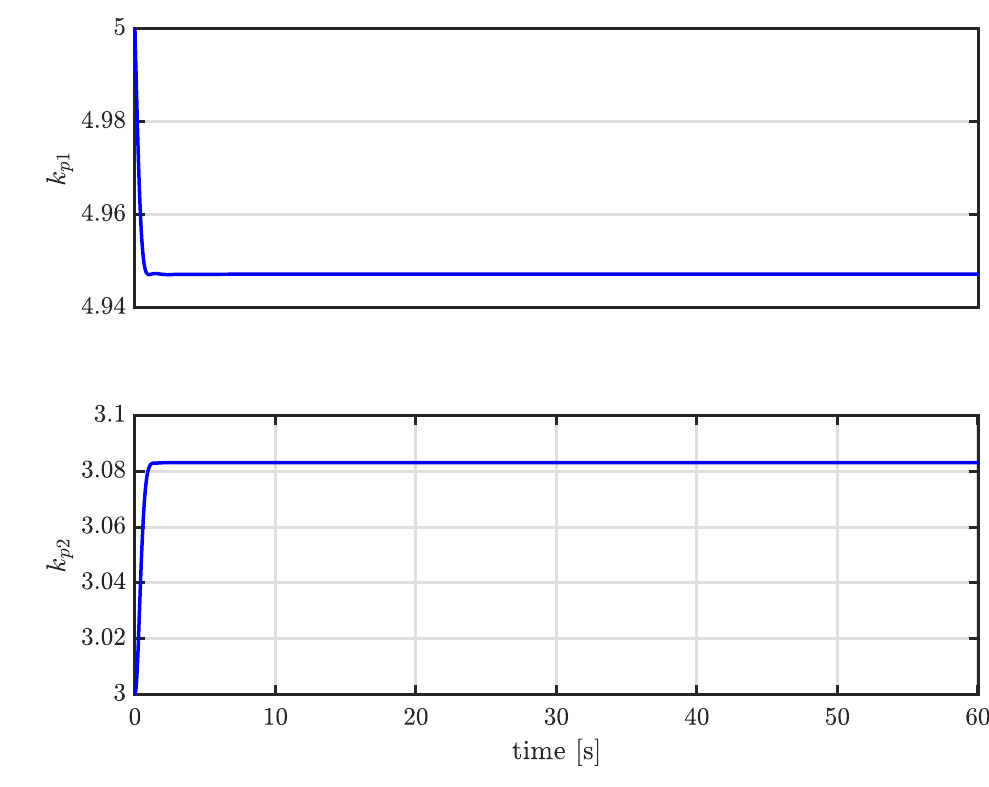
Figure 3. Control gains for pitch control (Case I-simulation).